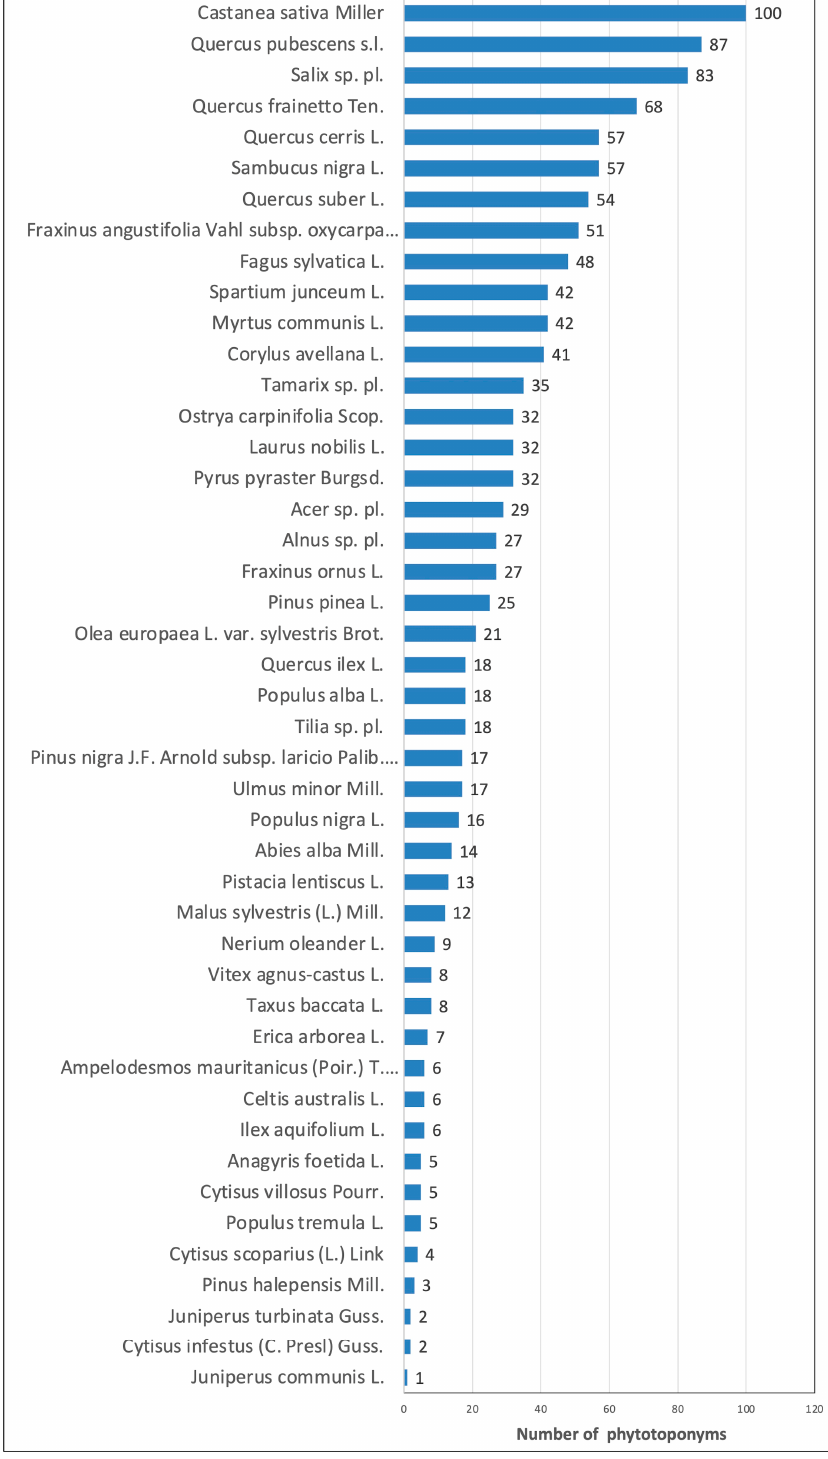
Figure 2 . Number of phytotoponyms per taxon. Figure 2. Number of phytotoponyms per